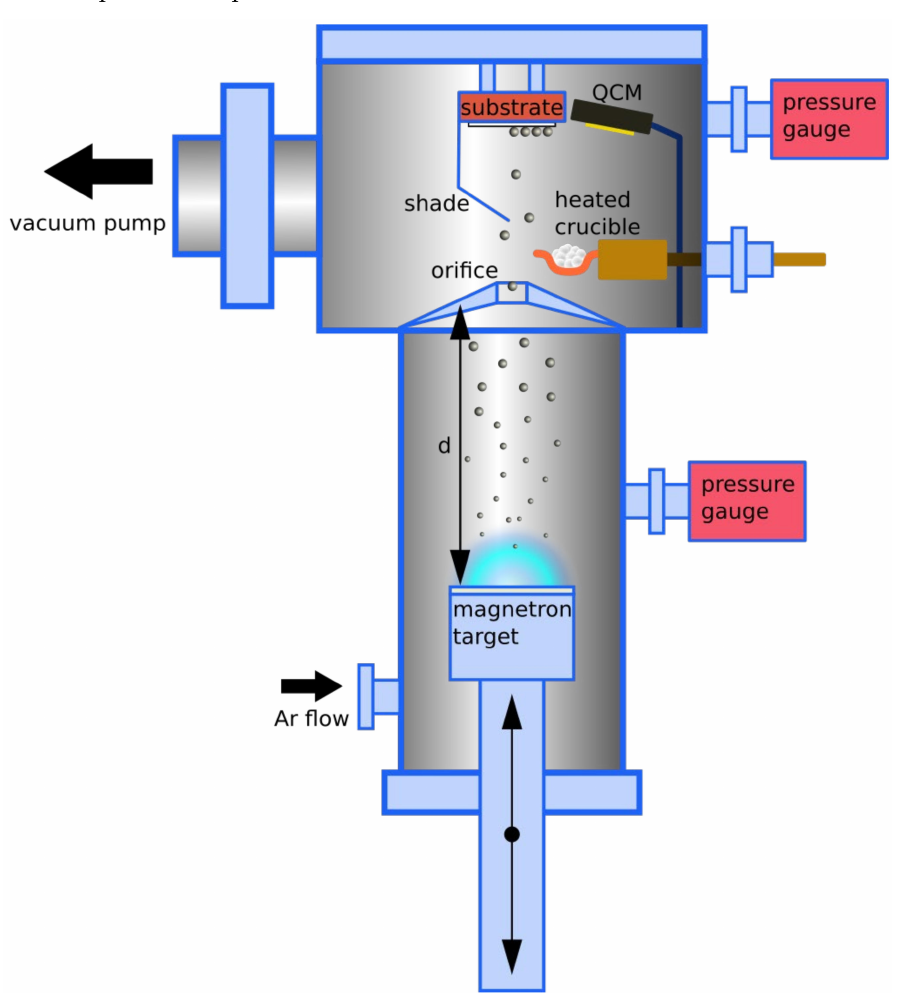
Figure 1. A schematic representation of the deposition apparatus. A special sample was deposited on a NaCl substrate for transmission electron mi- croscopy (TEM) measurement. A 15 nm layer of CaF 2 (Sigma-Aldrich, St. Louis, USA, 99.99%) was deposited, followed by a layer of Ag NPs (30 s deposition at 25 Pa). The resulting materials were covered by another 16 nm layer of CaF 2 . The CaF 2 layer was deposited via evaporation of powder from a molybdenum boat. The Ag NPs were prepared with a target–orifice distance of 60 mm. The sample was then placed on a wet surface while the NaCl substrate was diluted, and the floating layer was extracted by a copper grid. TEM measurements were performed on an FEI Tecnai TF20 X-twin microscope (FEI, Eindhoven, The Netherlands) operated at 200 kV (FEG, 1.9 Å point resolution) with an EDAX energy-dispersive X-ray (EDX) detector attached. The high-resolution (HRTEM) images were recorded on a Gatan UltraScan 1000XP CCD camera (Gatan, Pleasanton, USA) with a resolution of 2048 × 2048 pixels using the Digital Micrograph software (version 3.42.3055.00) package. Images were also acquired in scanning mode (STEM) using a high- angle annular dark field (HAADF) detector, which is sensitive to the atomic number (the heavier elements appear brighter). The EDX maps were recorded in scanning TEM (STEM) mode using the TIA software (FEI, Eindhoven, The Netherlands). The maps were calculated via the full quantification method using AgL, FK, CaK, and OK lines. Two classes of samples were fabricated to test the effect of Ag NPs on luminescence emission: a Eu 3+ -doped LaF 3 nanocomposite for the down-shifting emission